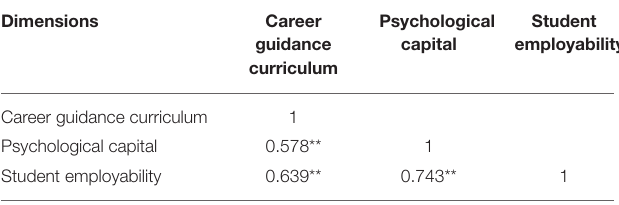
TABLE 8 | Correlation analysis of key variables.